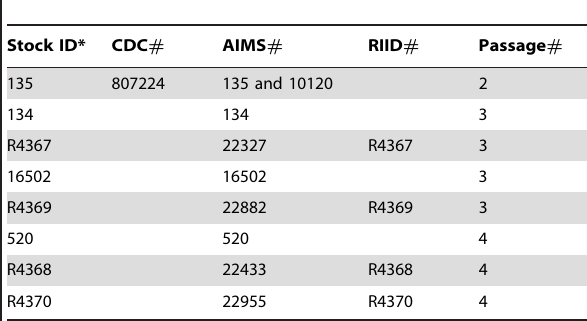
*Stock ID is used to identify the stock in the text.